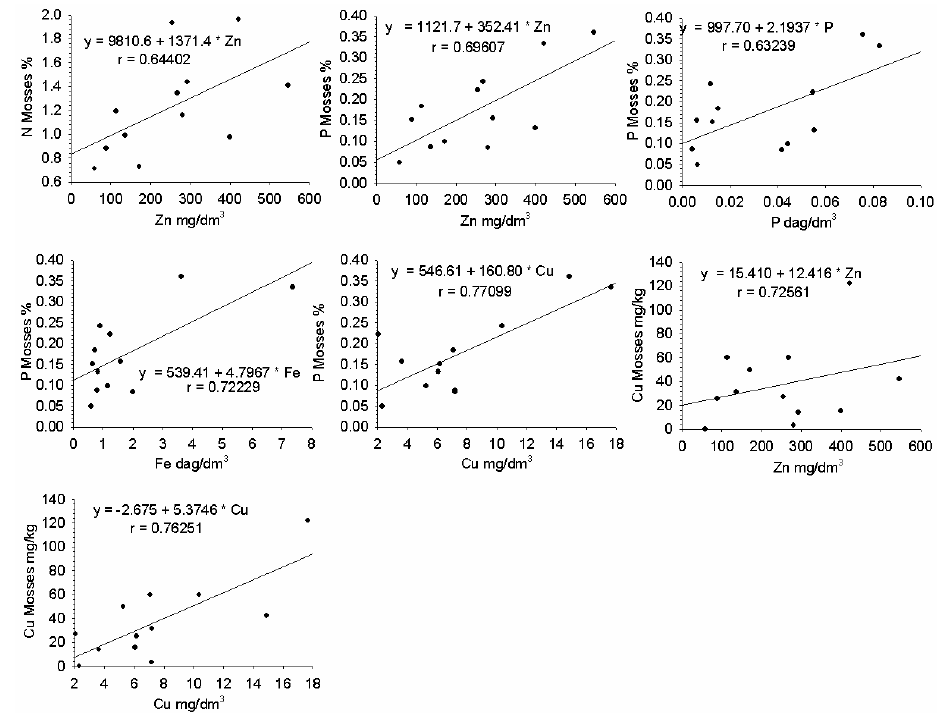
Figure 6. Graphs illustrating the correlation between soil macro- and micronutrients available and total plant amounts in